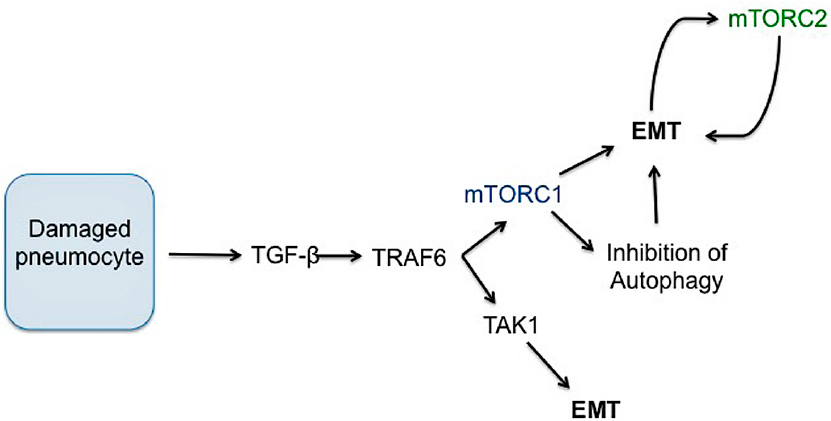
Figure 7. Potential roles of mTORC1 and mTORC2 in the development of EMT. TGF- β is important for the transdifferentiation of epithelial cells into fibroblast or myofibroblast-like cells. The exact roles of each mTOR complex are not clear in pulmonary fibrosis, but it is possible that the non-canonical TGF- β pathway contributes to mTORC1 activation, which induces EMT in lung epithelial cells near the site of injury. mTORC2 activity is induced in some cells undergoing EMT and may help ensure progression through the process. Rapamycin (mTORC1 inhibition) is capable of reversing EMT in some cells, suggesting transdifferentiation is disrupted.